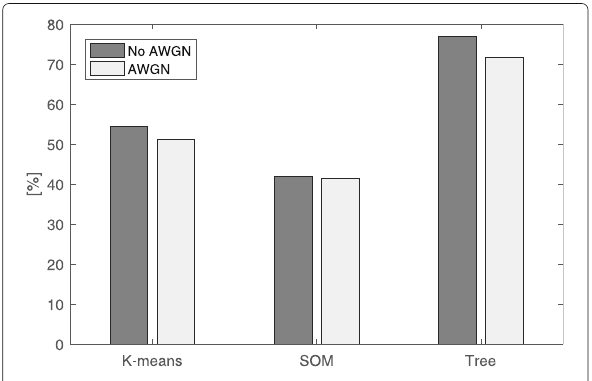
Fig. 8 Impact of noise on the global diagnosis success